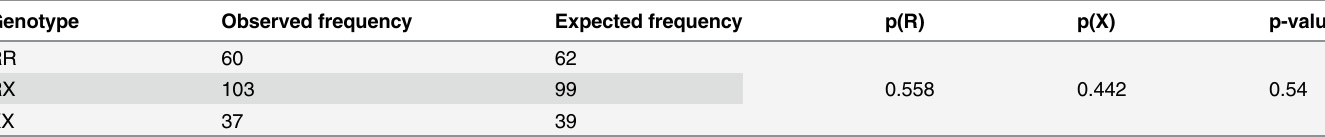
Table 1. ACTN3 R577X Allele Frequencies and Hardy-Weinberg Equilibrium.